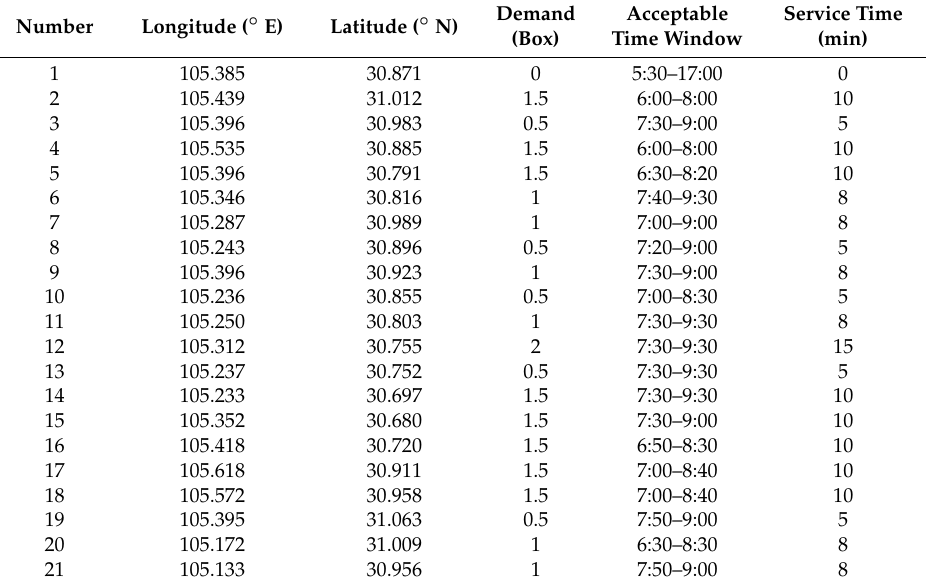
Table 2. Required information for MSDC and TMPs.